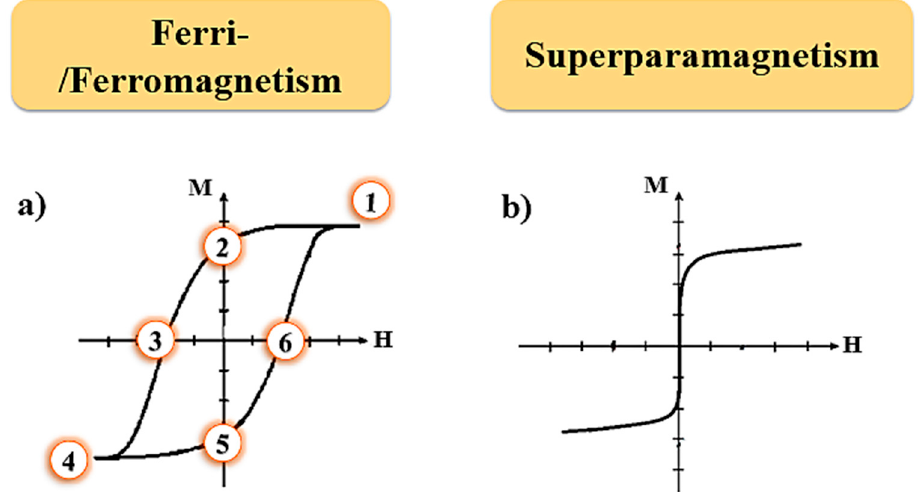
Figure 1. Magnetization curves versus applied magnetic field (M vs. H): ( a ) Typical magnetic hysteresis that occurs in both ferromagnetic and ferrimagnetic materials, where positions 1 and 4 represent the saturation magnetization, and positions 2 and 5 represent the remanence of material; (3) and (6) correspond to the coercivity in two opposite directions of the applied magnetic field; ( b ) Behavior of a superparamagnetic